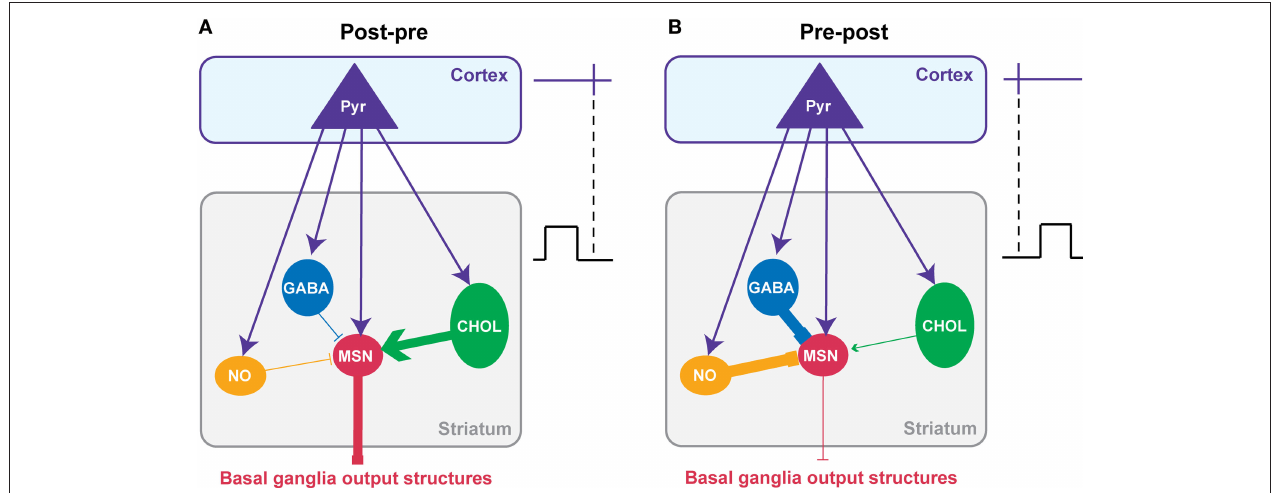
FiGure 5 | Putative functional consequences of corticostriatal STDP cell-specificity on the striatal output. A simplified model of the interplay of the STDP occurring at the different striatal neuron populations taking into account the main synaptic interactions between striatal interneurons and MSNs. The effects of the combined STDP on the striatal output were considered after post-pre (A) or pre-post pairings (B) . (A) Post-pre pairings induced a depression of the